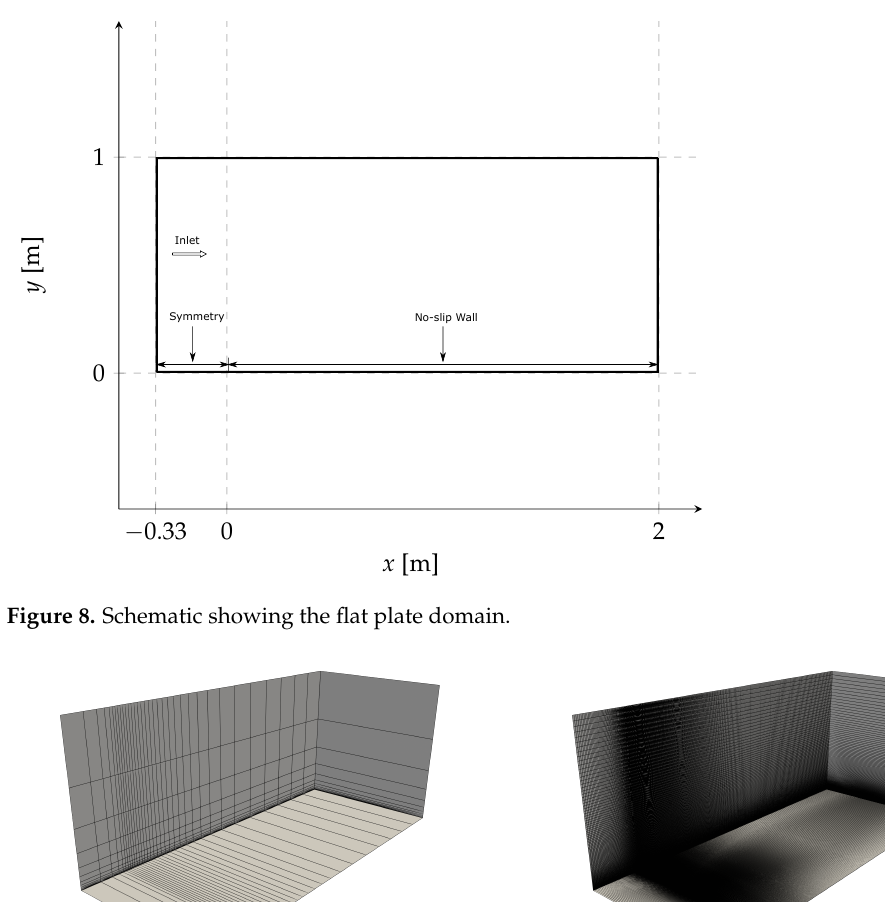
25 and (b) 545 385 × × 25 and (b) 545 385 25 and ( b ) 545 385. × × × ×